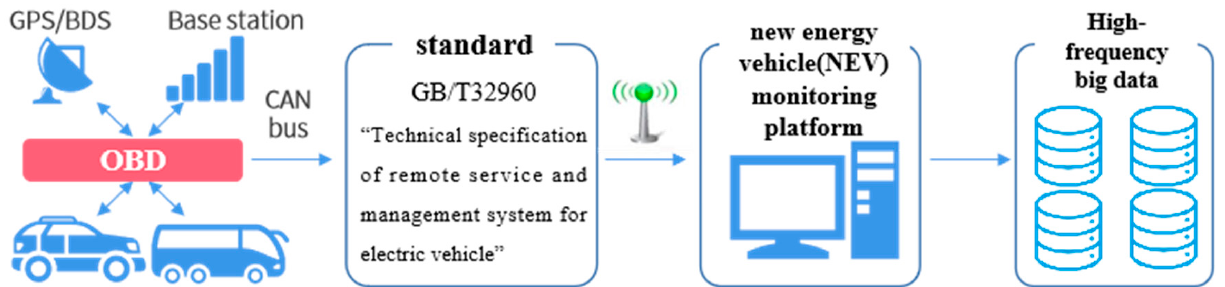
Figure 1. Flow chart of high-frequency big data collection for new energy vehicles.